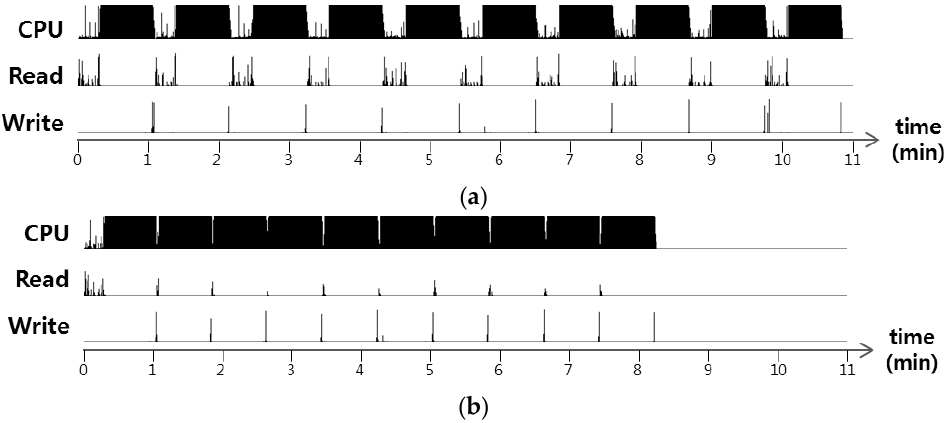
Figure 3. CPU and I/O activities in desktop rendering. ( a ) Results for original system configurations. ( b ) Results when all file data are simultaneously loaded in memory.